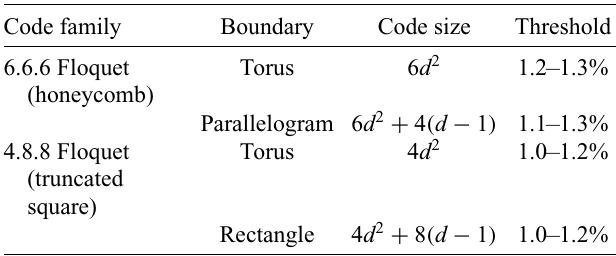
TABLE II. Threshold estimates for code implementations with two-qubit Pauli measurements. The effective distance d is for a circuit-noise model with two-qubit correlated errors. For the 4.8.8 code, the torus distance must be even and the rectangle dis- tance must be odd. Note that for a square grid of Majorana-based qubits, the code size coincides with the number of qubits required for